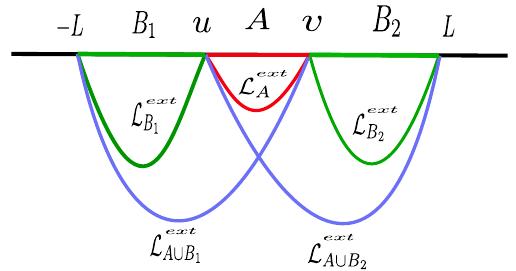
Fig. 1 Schematic of extremal surfaces anchored on the subsystems A , B 1 and B 2 which live on the (1 + 1)-dimensional